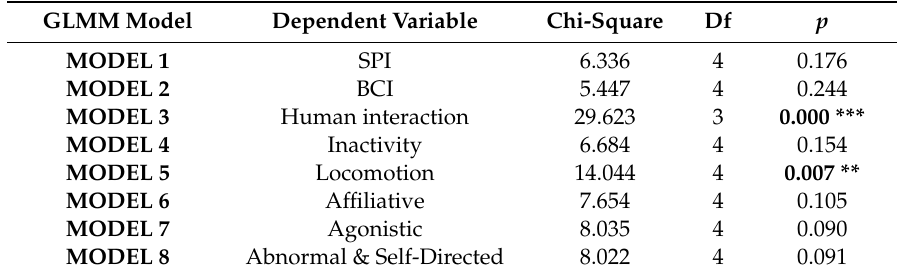
Table 5. List of all generalized linear mixed models (GLMMs) and the results from the likelihood ratio test between the respective null and full